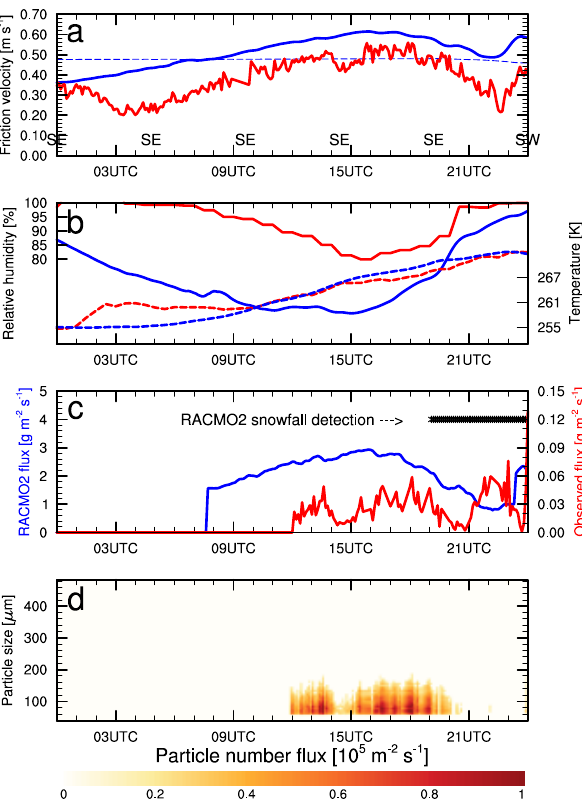
Fig. 7. Time evolution on 24 September 2012 of (a) observed (red) and simulated friction velocity (blue) and wind direction (indicated above bottom axis), and threshold friction velocity for drifting snow in RACMO2 (dashed blue); (b) observed (red) and simulated (blue) relative humidity (solid) and temperature (dashed) at ∼ 1m above the surface; (c) observed (red) and simulated (blue) single-level (1m) drifting snow transport (mind the different scales); and (d) observed number of snow particles per particle size. The crosses in (c) indicate the occurrence of snowfall in